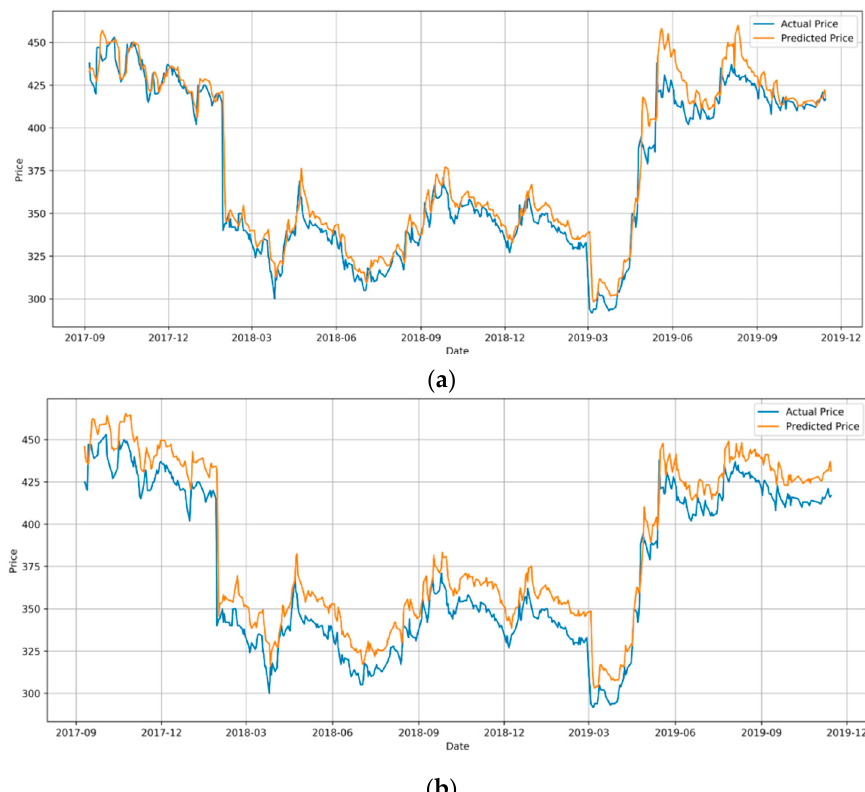
Figure 6. The actual and predicted price of agriculture development bank (ADBL) from 12/09/2017 to 14/11/2019. ( a ) LSTM; ( b ) GRU.